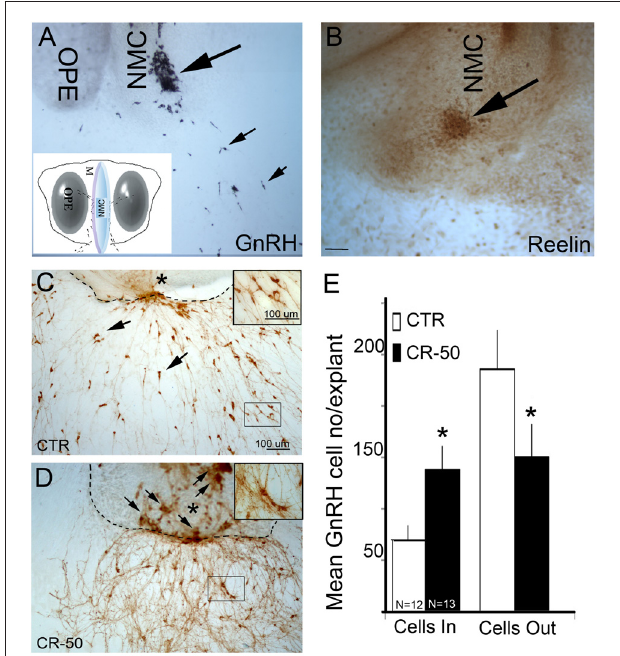
FIGURE 1 | Reelin signaling blockade in vitro decreases gonadotropin releasing hormone-1 (GnRH) neuronal migration. (A) GnRH cells (blue-black, small arrows) have migrated into the periphery of the explant by 3 div , although large numbers remain at the tip of the nasal midline cartilage (NMC, large arrow). Inset: schematic of nasal explant (OPE, olfactory pit epithelium). (B) Immunostaining with antibody against Reelin in a 3 div explant, shows strong expression of Reelin (brown, arrow) at the tip of NMC. Reelin is expressed by mesenchymal cells in the area where GnRH neurons migrate into the periphery (Compare large arrows in A–D ). 7 div explants immunostained with antibody against GnRH (brown) after chronic treatment (from 3–6 div ) either with vehicle (CTR) (C) or CR-50 antibody (D) , an antibody known to block the effect of Reelin. Dash lines indicate border between the main tissue mass and the periphery of the explant, asterisk indicates tip of NMC. Under control (CTR) conditions, GnRH-positive cells are dispersed outside the main tissue mass ( C , arrows), in the periphery of the explants. After CR-50 treatment, the majority of the GnRH neurons remained within the main tissue mass ( D , arrows) and fewer cells migrated into the periphery. (E) Quantitative analysis of GnRH cell distribution in the inner tissue mass and in the periphery under the two experimental conditions. The total number of GnRH cells did not change between control and treated explants. However, following CR-50 treatment significantly more GnRH neurons remained within the inner tissue mass (Cells In) as compared to control conditions ( ∗ P < 0.01; Student’s t -test). Concomitantly significantly less cells under CR-50 treatments were counted outside the main tissue mass (Cells Out) compared to CTR ( ∗ P < 0.01; Student’s t -test). Scale bar = 100 µ m in (C) (same magnification A,D ). Scale Bar = 50 µ m in (D)